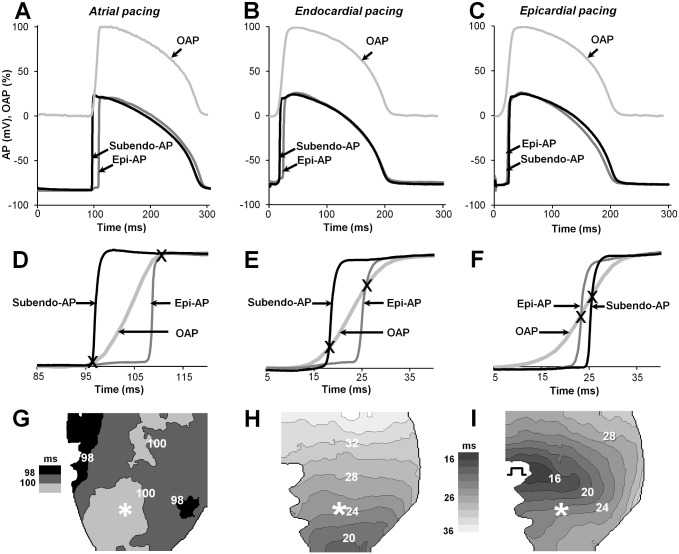
Characterization of optical and electrical APs using various stimulations of a whole rabbit heart.
(A-C) Examples of simultaneous recordings of an OAP (light gray) and two APs, epicardial (gray) and subendocardial (black). The start time of the OAP was synchronized with that of the electrical APs. (D-F) Superimposition of the upstrokes of the subendo-/epi-AP and OAP from A-C on an expanded time scale. The cross indicates the crossing point between the OAP and the APs obtained from subendo- and epicardium. (G-I) OAP activation-time maps for atrial/endocardial/epicardial pacing. The interval between the isochrones (black lines) is 2 ms. Numbers near isochrones show the activation time in ms. The asterisks and the square pulse indicate the location of the microelectrodes and the stimulating electrode, respectively, on the epicardial surface. Stimulation period: 300 ms.